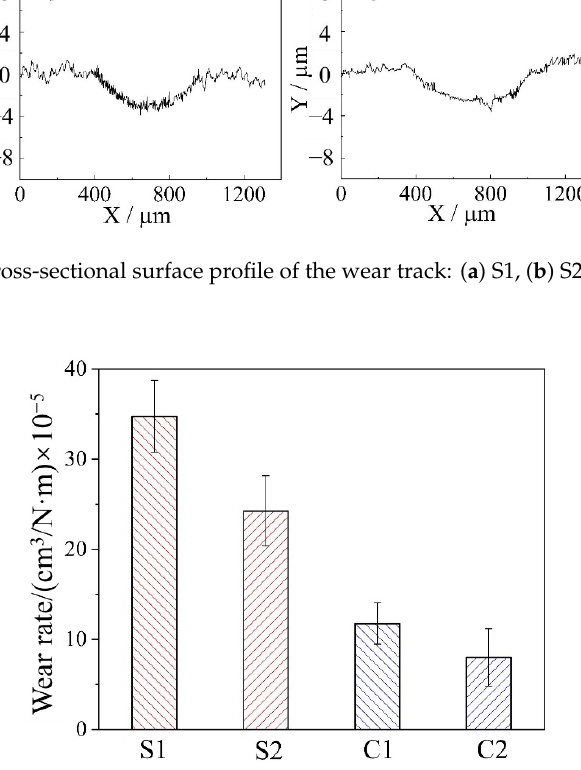
Figure 9. 2D cross ‐ sectional surface profile of the wear track: ( a ) S1, ( b ) S2, ( c ) C1, ( d ) C2.